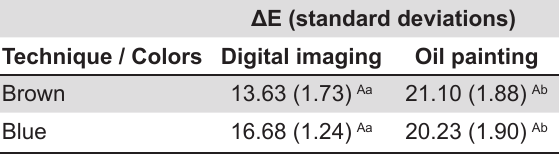
Table 1- ΔE means (standard deviations) for each technique and color used for reproducing artificial irises